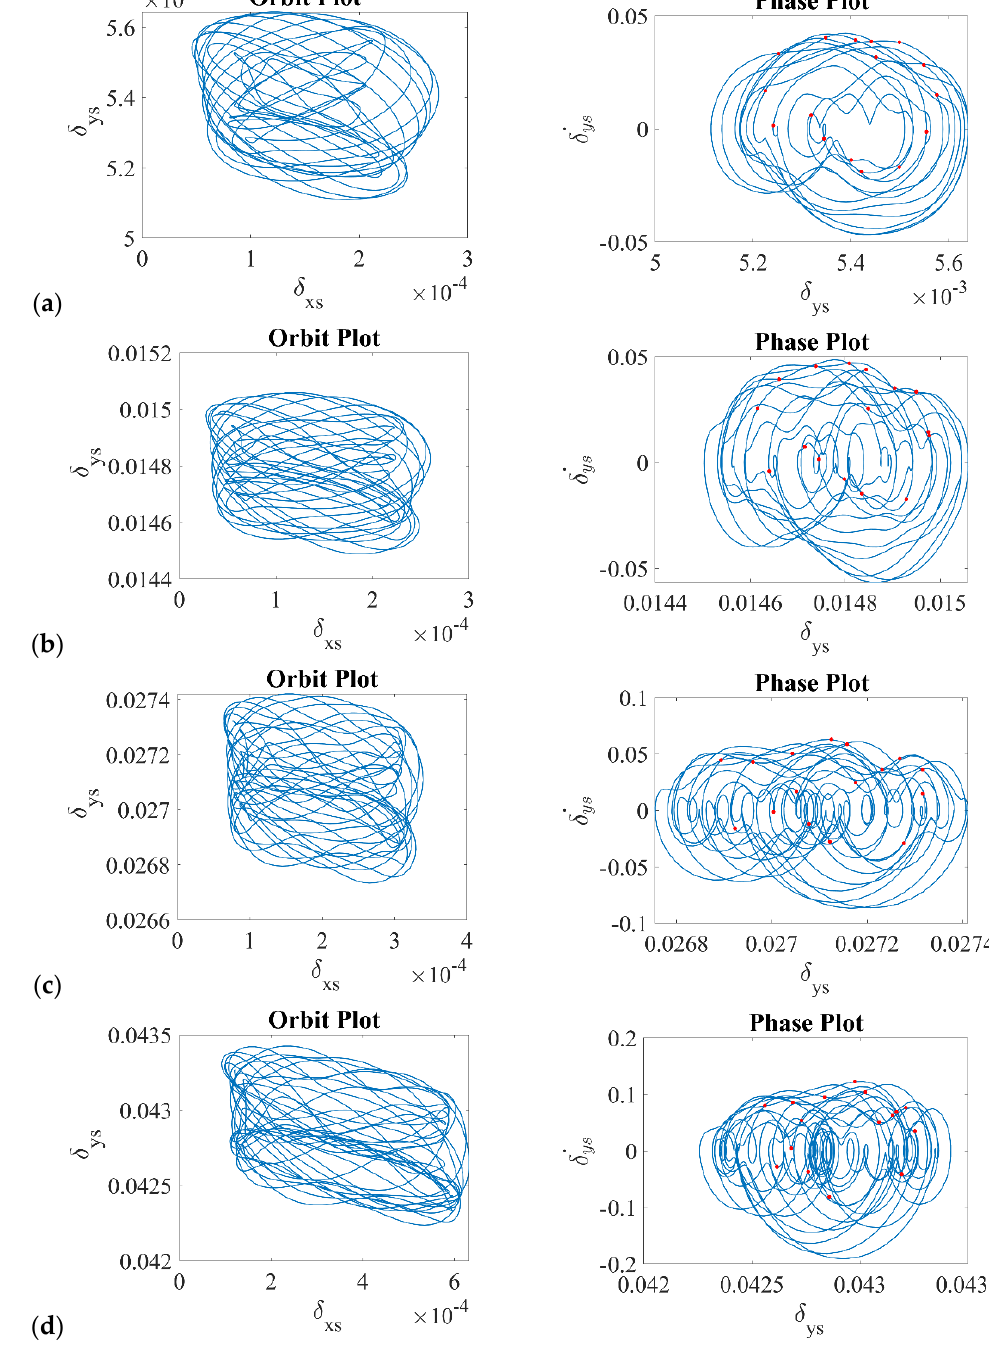
Figure 6. Orbit and phase plots for ( a ) RIC = 5.5 μm, ( b ) RIC = 16 μm, ( c ) RIC = 30 μm, ( d ) RIC = 48 μm.